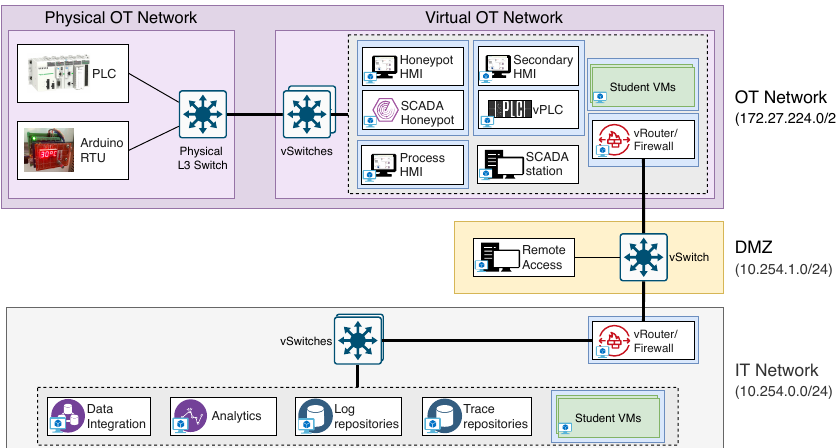
Figure 6. Logical network topology for the full cyber range